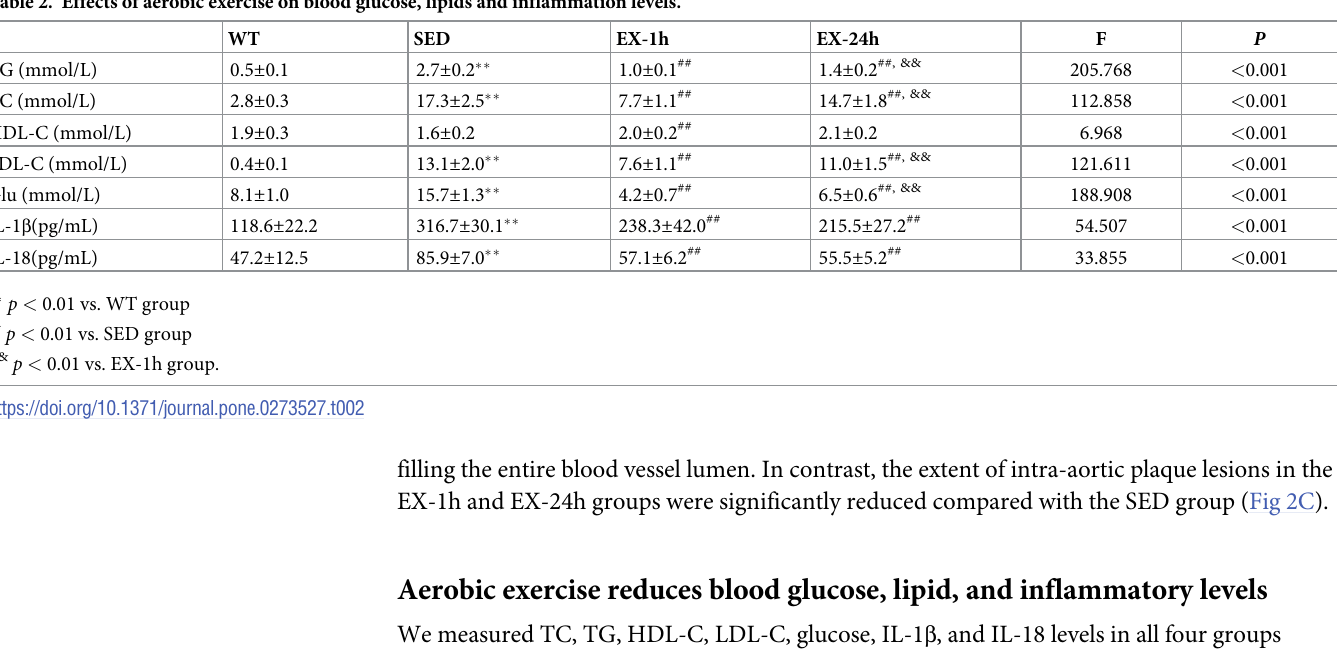
Aerobic exercise reduces blood glucose, lipid, and inflammatory levels (Table 2). Compared with the WT controls, the SED group had high blood glucose, lipid, and inflammatory levels ( p < 0.05). Both EX-1h and EX-24h groups presented lower blood glucose, lipid, and inflammatory levels than the SED group ( p < 0.05).